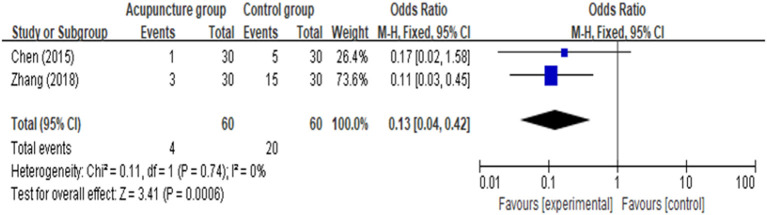
Meta-analysis and forest plot for nausea/vomiting.